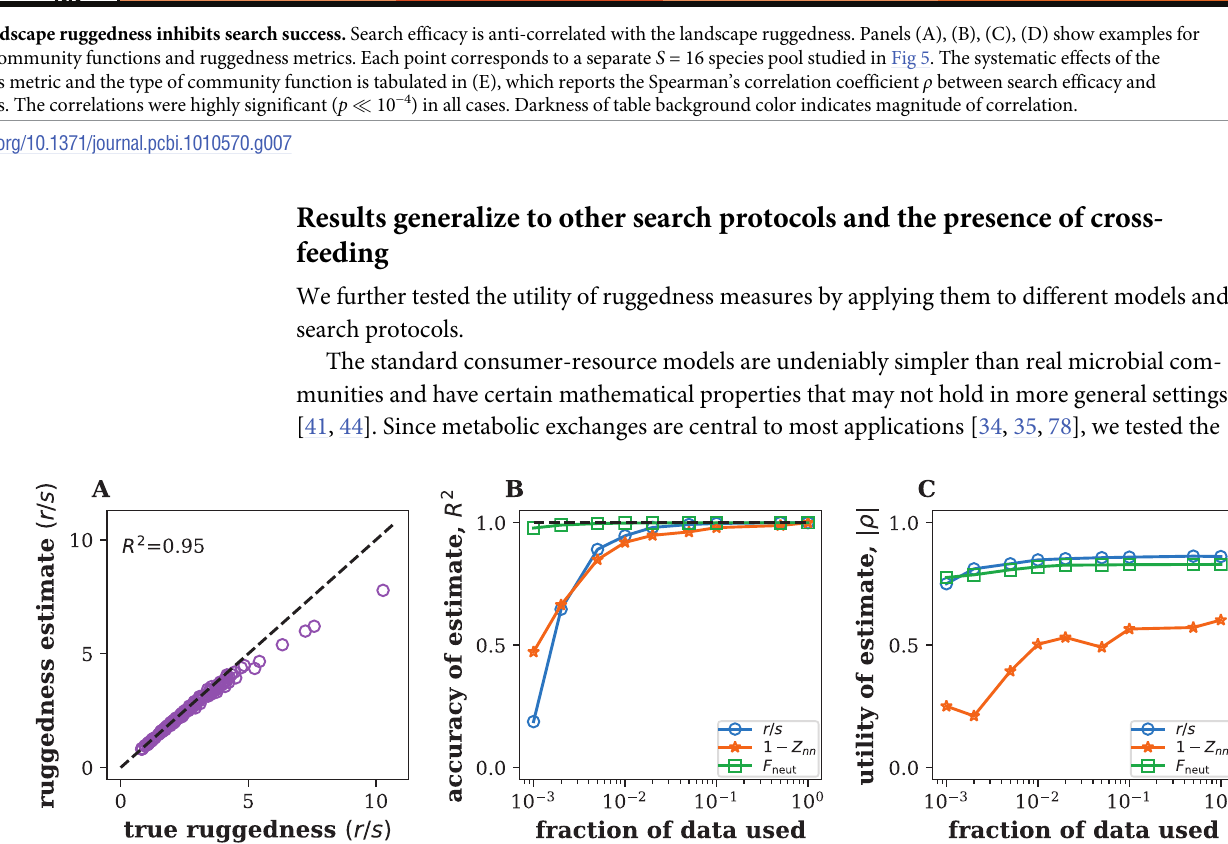
Fig 8. Estimating ruggedness from limited data. (A) True and estimated ruggedness are tightly correlated when only 1% of the data is available for the estimation. The data are from Fig 5, and each point corresponds to a landscape with a different degree of niche overlap. (B) The accuracy of the estimation improves with the amount of available data for all ruggedness measures. (C) The estimated ruggedness remain highly informative of search efficacy. The utility of the ruggedness estimate, | ρ |, is measured as the magnitude of the Spearman’s correlation coefficient between search efficacy and estimated ruggedness. Note that | ρ | remained close to one even for very low fractions of the data for which R 2 in panel B started to decrease rapidly suggesting that deviations between predicted and actual roughness (see A and B) do not impede the prediction of search success. For this figure, the community function is the Shannon diversity. Similar results were obtained for other functions tested.